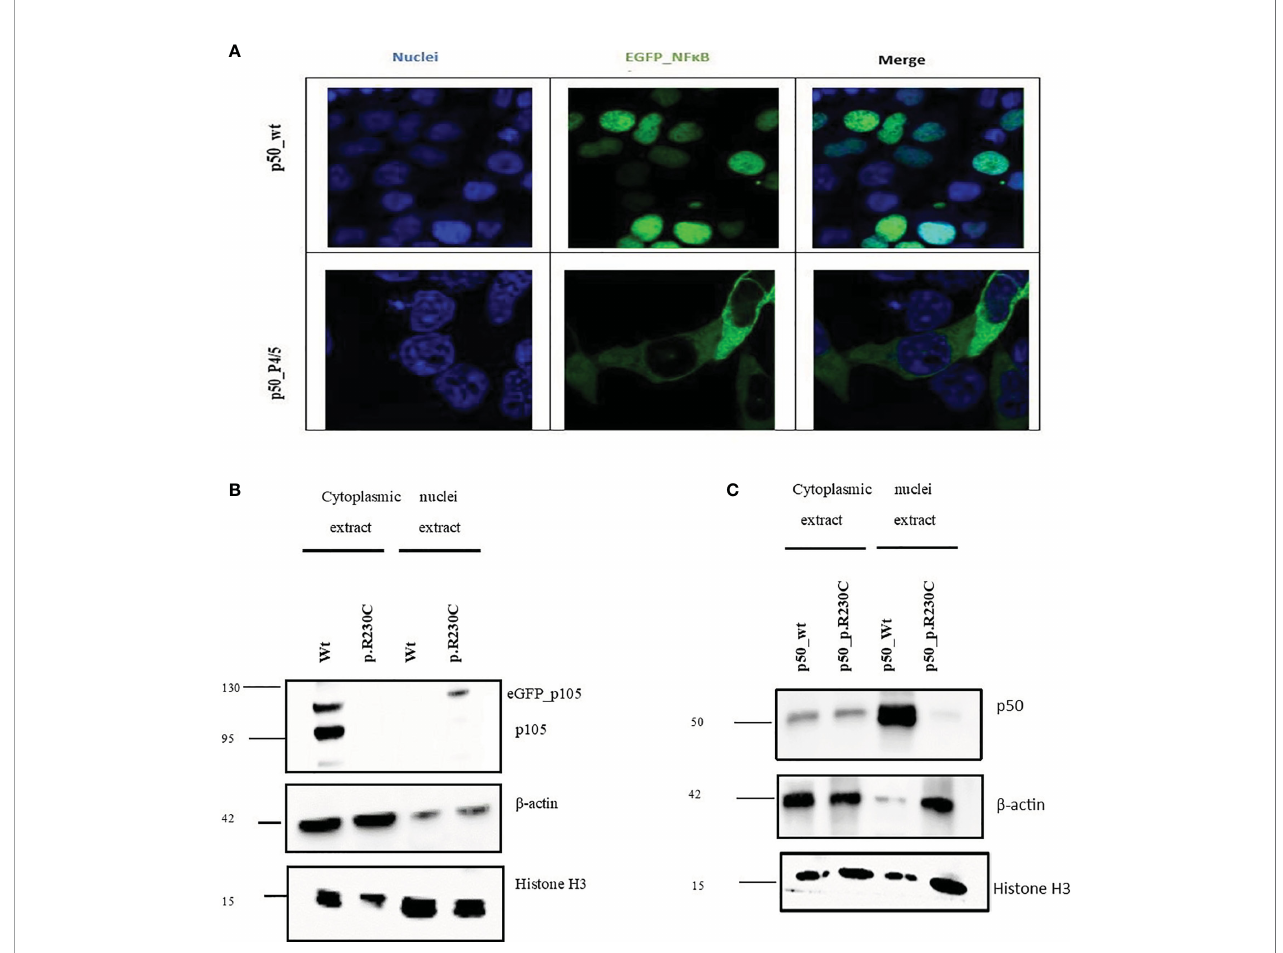
FIGURE 2 | NFkB1 expression in and nuclear translocation in transfected HEK293 cells. Total proteins were extracted from transfected HEK293 cells to determine the expression of p105/50. (A) For microscopic analysis of NFkB1-p50 translocation into the nucleus, HEK293 cells transiently expressing the eGFP-p50 wild type and mutant were used. Nuclei were stained with DAPI. The wild-type p50-construct localizes into the nucleus while the mutant p50-construct was retained in the cytoplasm. (B) Western blot to analyze the effect of the variant on the expression of p105/50 in the transfected HEK293 cells. The expression in the wild type was prominent in the wild type, while no noticeable expression in the variant was observed. (C) p50 expression in HEK293 showed an increase in wild-type and a decrease in the mutant (p. R230C) in the nuclear